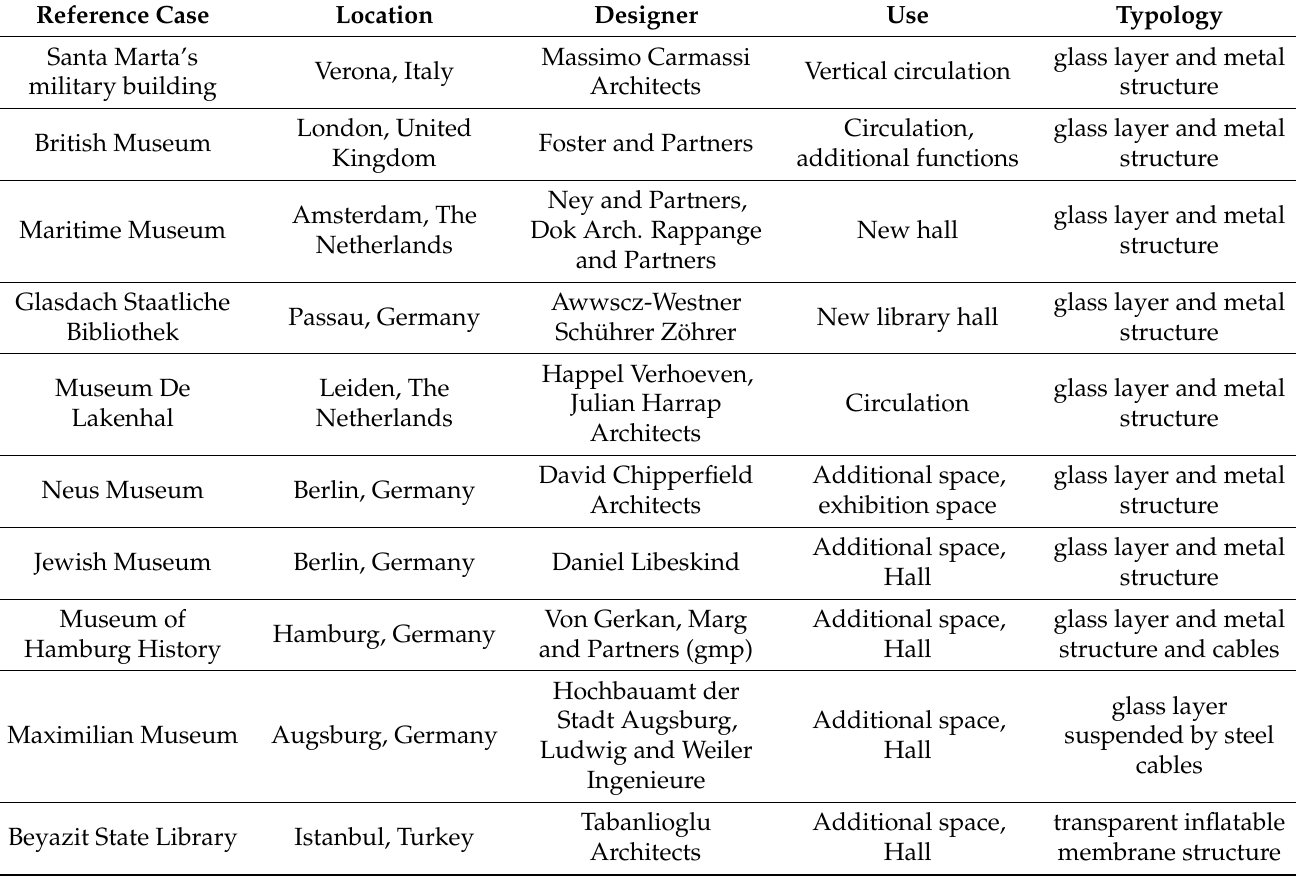
Table A1. Reference cases of covered courtyards after the